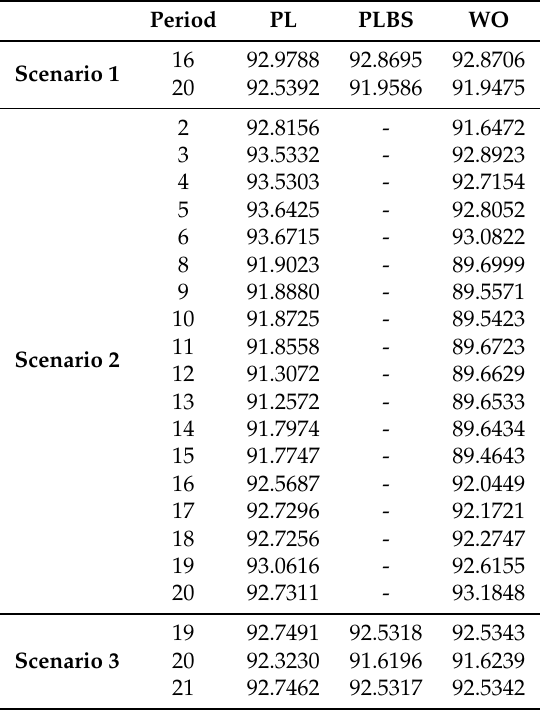
Table 13. Mean efficiency values (%) in all